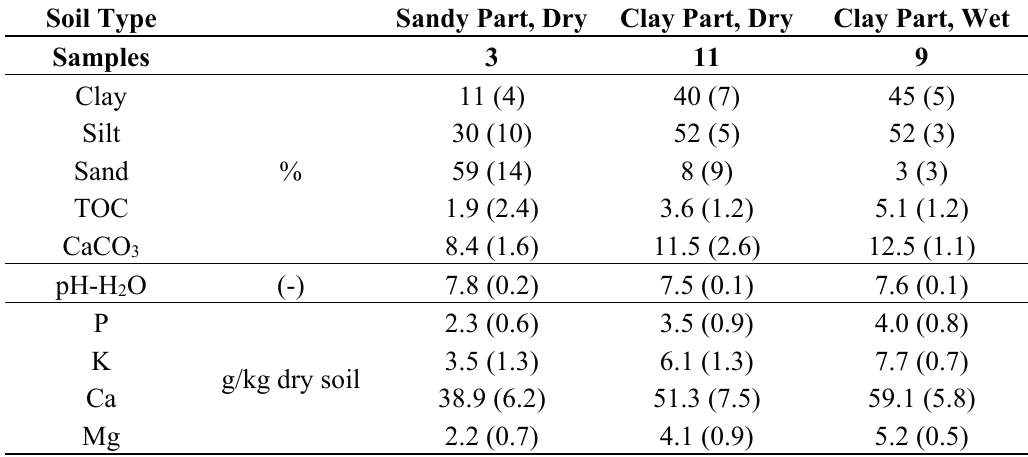
Table 1. Soil properties of the dredged sediment landfill site sampled on 23 points of a regular grid, grouped for the three parts of the site (“sandy part, dry”: sandy part, already emerged in 2003; “clay part, dry”: clay part, already emerged in 2003; “clay part, wet”: clay part, still submerged in 2003). Values are averages, with standard deviation in brackets (TOC, total organic carbon; EC, electrical conductivity). Samples were taken in 2003, except for S, EC and SO 4 , which were taken in